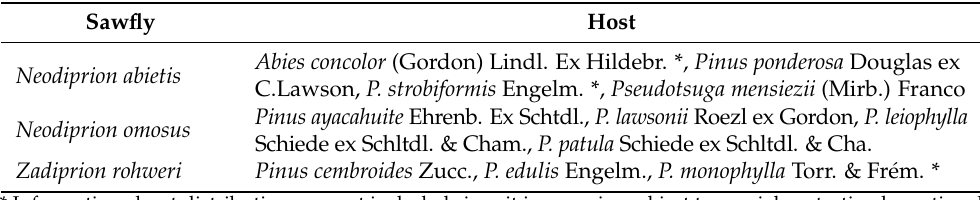
Table 1. Species of sawfly (Hymenoptera: Diprionidae) and their hosts recorded in Mexico. Sawfly Host